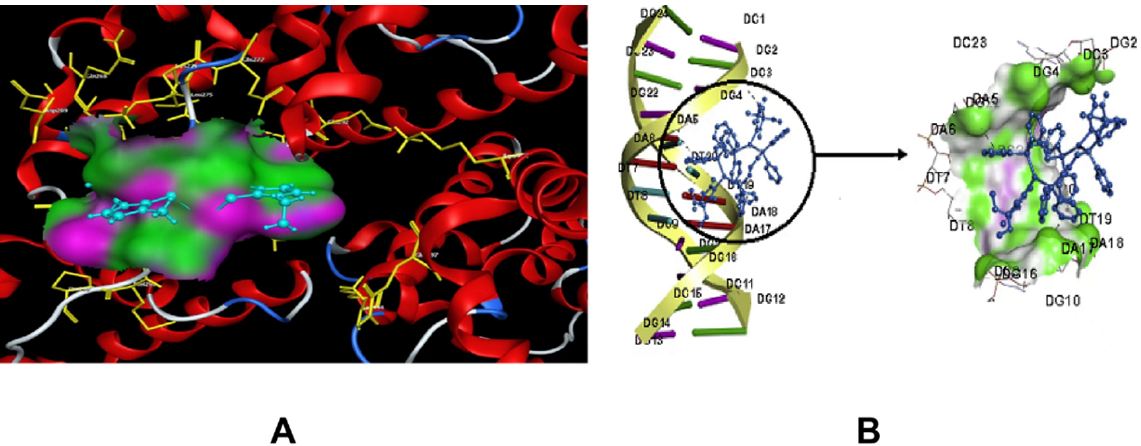
Figure 11. ( A ): The hydrogen bond (violet) and the hydrophobic interactions (green) between the cationic moiety of the asymmetric unit of polymer 1 and HSA. ( B ): Molecular docked structures of [Ag 2 (barb)2(u-dppp) 2 ] with DNA (barb = 5,5-diethylbarbiturate), (dppm = 1,1- bis(diphenylphosphino)methane). Reproduced with permission from